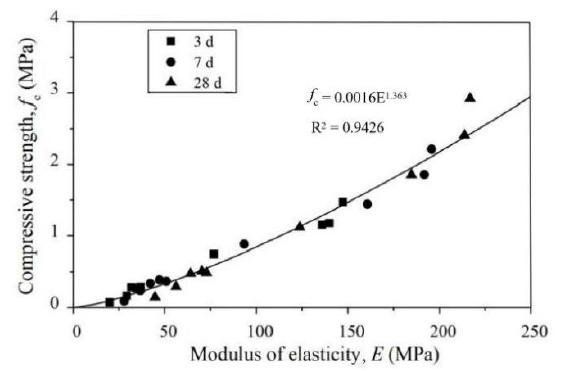
Figure 10. Relationship between compressive strength and modulus of elasticity.